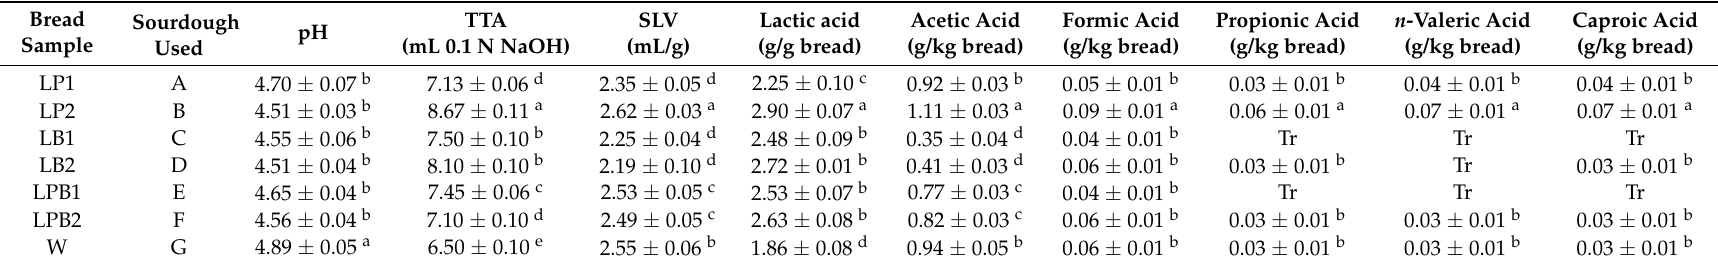
Table 2. Physicochemical characteristics (acidity, volume, moisture loss, and organic acids content) and shelf-life of breads made with sourdoughs prepared with freeze dried L. paracasei K5 and freeze-dried L. bulgaricus ATCC 11842 as well as with the control sourdough. Bread Sample